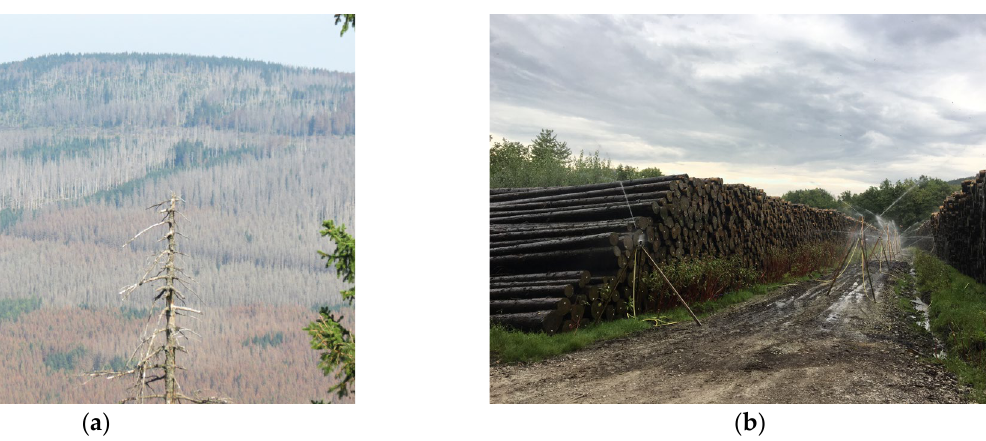
Figure 1. Calamity timber ( a ) Norway spruce forests in the Harz mountains, Germany, after severe attack by bark-breeding beetles (Photo: S. Bollmus, 2021); ( b ) Sprinkling of spruce logs in a wet storage near Glashütte, Lower Saxony, Germany (Photo: L. Emmerich, 2019).